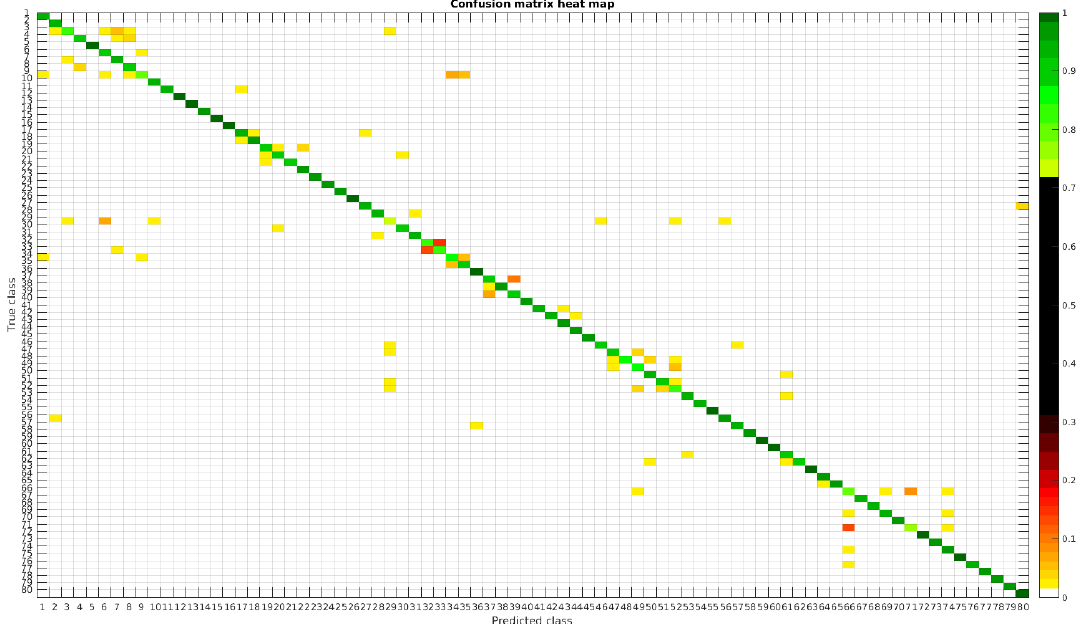
Figure 13. Confusion matrix heat map for the normalized dataset with 300 samples per class.